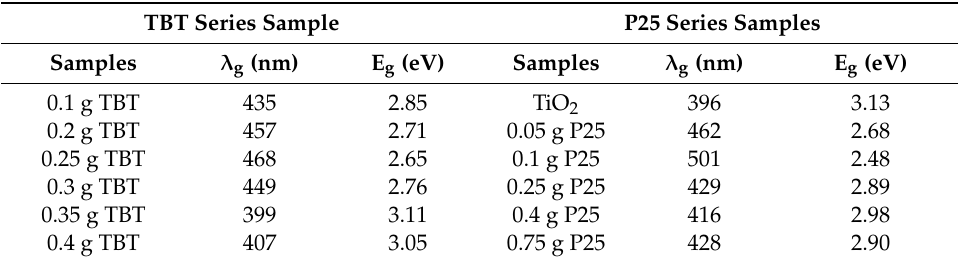
Figure 6. UV-Vis absorption spectra of P25 series samples ( a ) and TBT series samples ( b ). Table 3. The Absorption wavelength thresholds and corresponding band gaps of all samples.